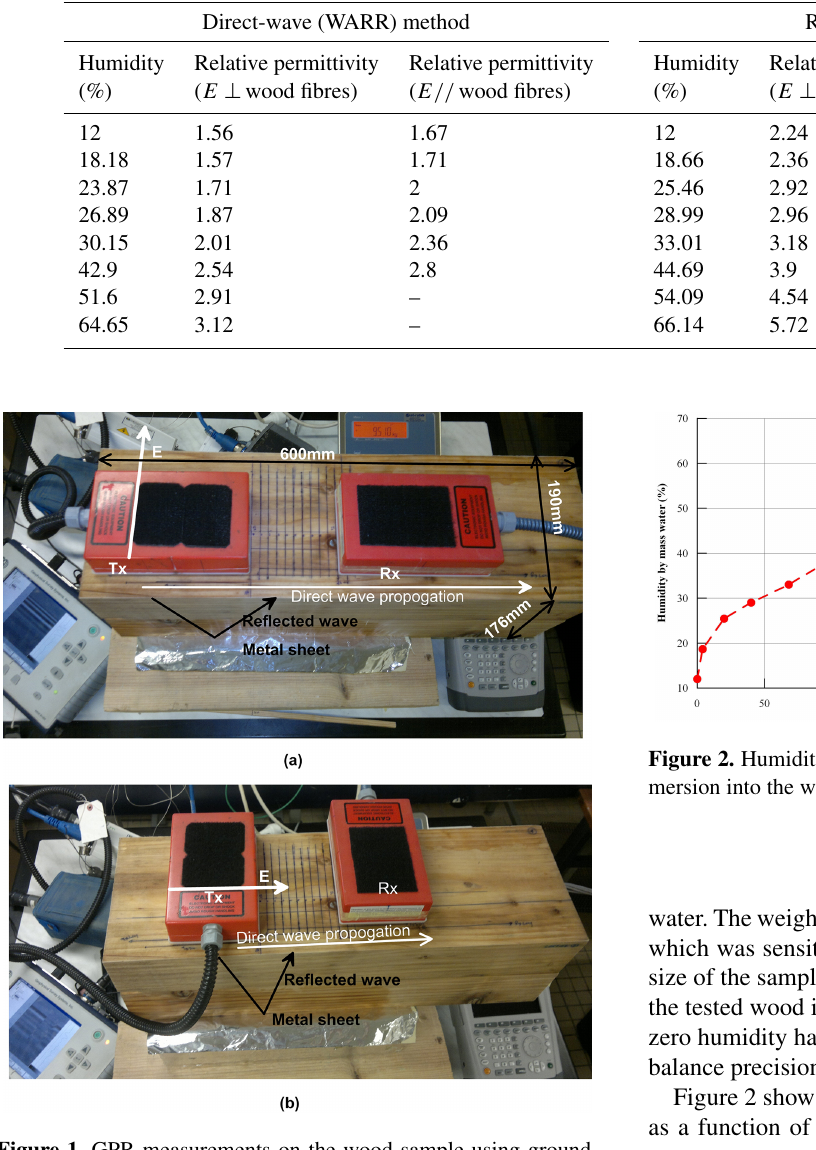
Table 1. Relative permittivity of wood for different levels of humidity by mass water, for direct- and reflected-wave approaches.